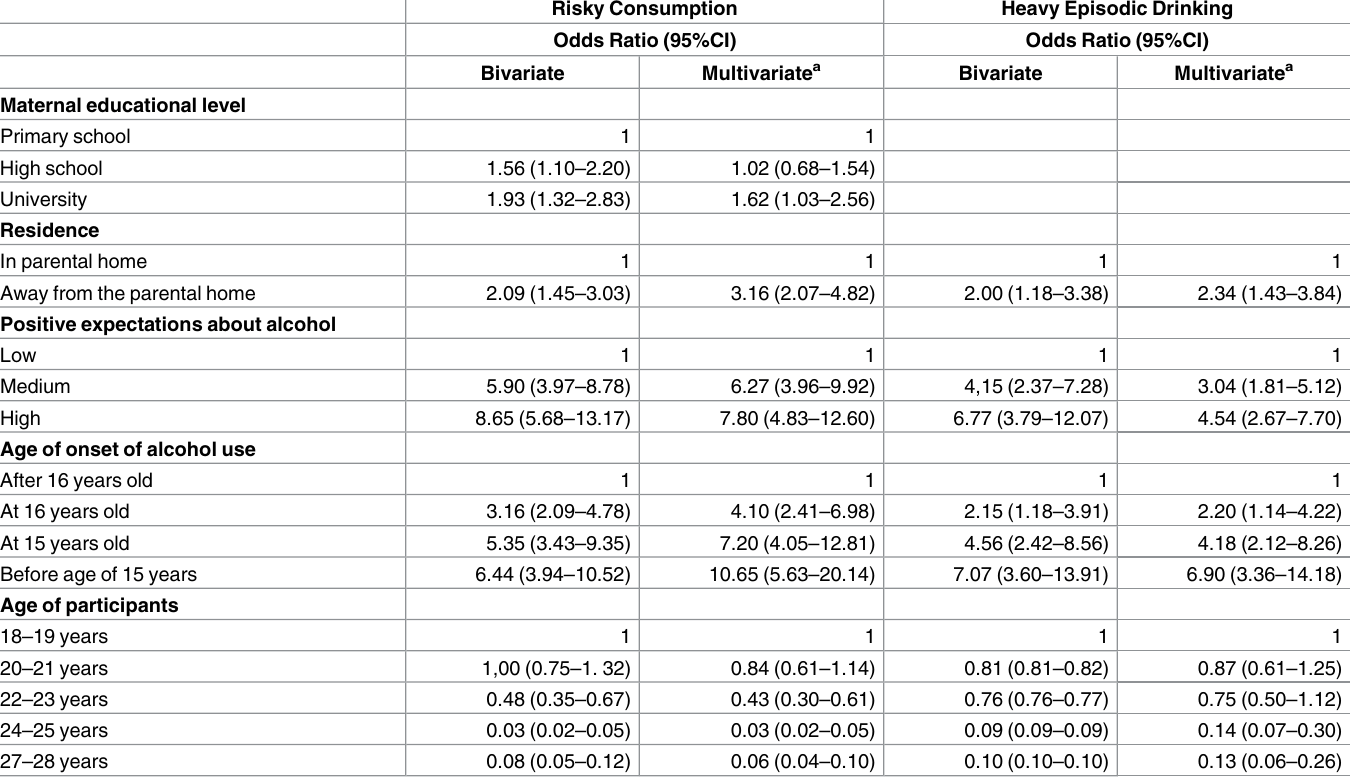
Table 5. Influence of characteristics of female subjects and family background on risky consumption and heavy episodic drinking: Generalized Linear Mixed